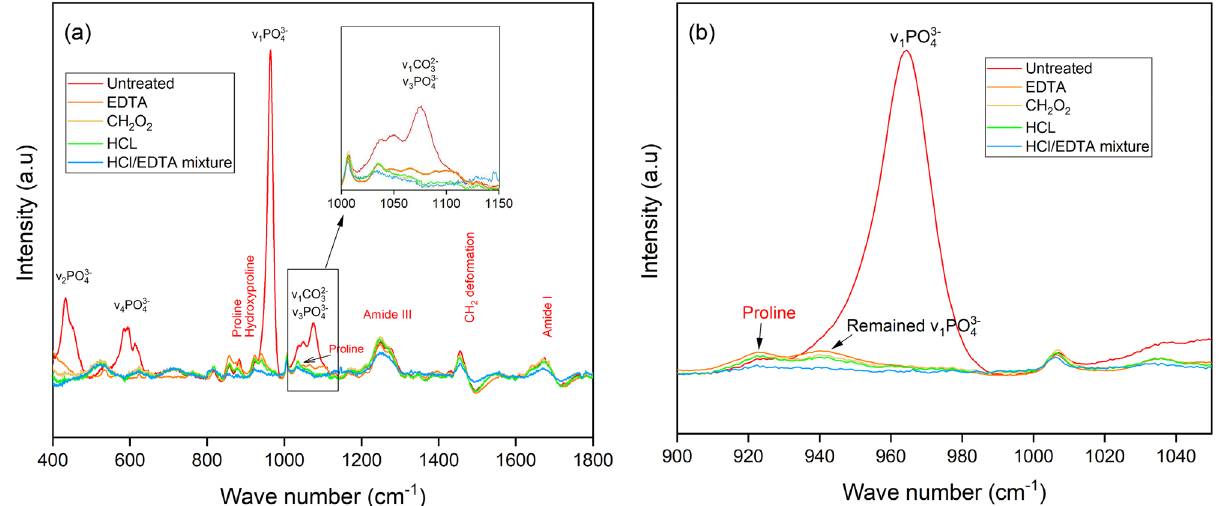
Figure 1. (a) Representative Raman spectra indicate mineral and collagen bands for the untreated bone, and for bone treated with ethylene-diamine tetraacetic acid (EDTA), formic acid (CH 2 O 2 ), hydrochloric acid (HCl), and the HCl/EDTA mixture. Top right image is an enlarged figure for the overlapping bands of v 3 PO and v 1 CO. (b) Outlined area in (a) with a solid border is shown with the primary phosphate